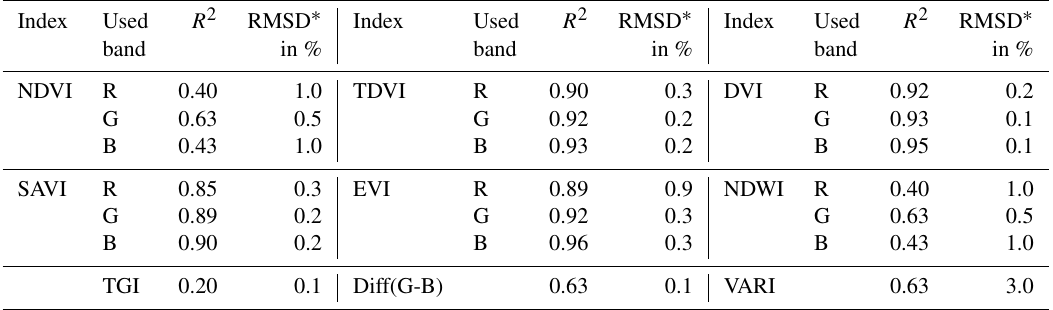
Table 2. R 2 ( p < 0 . 05) between vegetation indices integrating red, blue, and green bands and the reflectances in NIR for all considered samples, and the RMSD between indices derived from MSI and OLI sensor